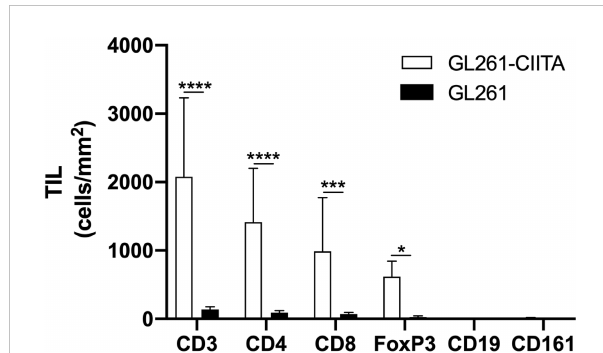
FIGURE 2 GL261-CIITA tumors are strongly in fi ltrated by both CD4 and CD8 T cells: quanti fi cation. C57BL/6 mice received intracranial injection of 3 × 10 4 GL261 or GL261-CIITA glioma cells. On day 21 after injection, mice were sacri fi ced, brains were removed, and serial sections of the brain were carried out for staining with anti-CD3, anti-CD4, anti-CD8, anti-FoxP3, anti-CD19, and anti-CD161 antibodies. Bars represent the average number of CD3, CD4, CD8, FoxP3, CD19, and CD161 tumor-in fi ltrating lymphocytes (TILs) measured from histopathological sections, as indicated in the Materials and Methods section. Bars represent mean values, and error bars indicate the SD for each group; n = 7. p -Values were determined via unpaired t test; CD3: **** p < 0.0001; CD4: ****p < 0.0001; CD8: ***p < 0.001; FoxP3: *p < 0.05. Neither CD19